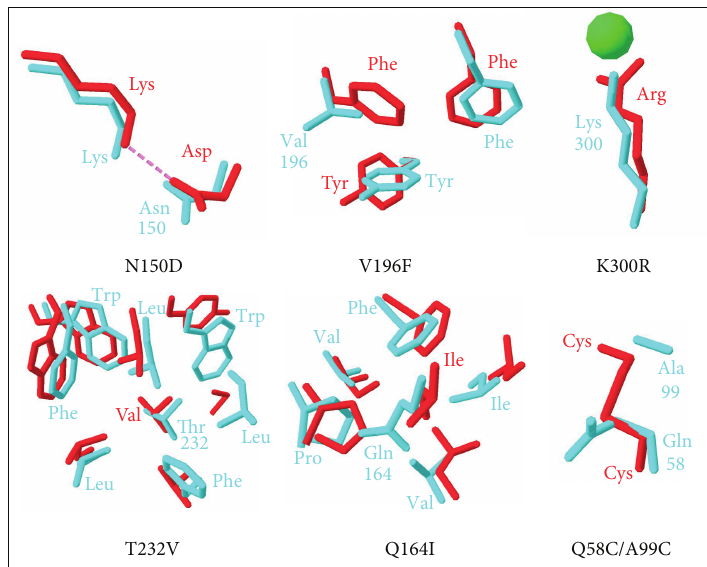
F 11: Amino acid substitutions in a psychrophilic alpha-amylase (blue) in comparison with the structure of its mesophilic homologue (red). e substitution N150D disrupts a salt bridge with the corresponding Lys side chain in the cold-adapted protein. e substitution V196F disrupts a triple face-to-edge aromatic interaction. Substitution K300R results in a monodentate coordination of the chloride ion, instead of a bidentate coordination by Arg in the mesophilic protein, as demonstrated by the crystal structure of the single mutant [272]. Substitutions T232V and Q164I decrease the apolarity of hydrophobic core clusters in the psychrophilic enzyme and the double substitution Q58C/A99C eliminates a disul�de bond. Adapted from